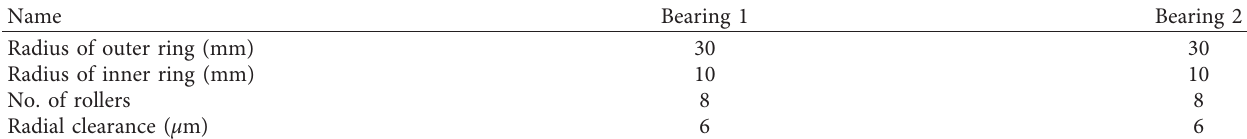
Table 2: Parameters of the bearings.